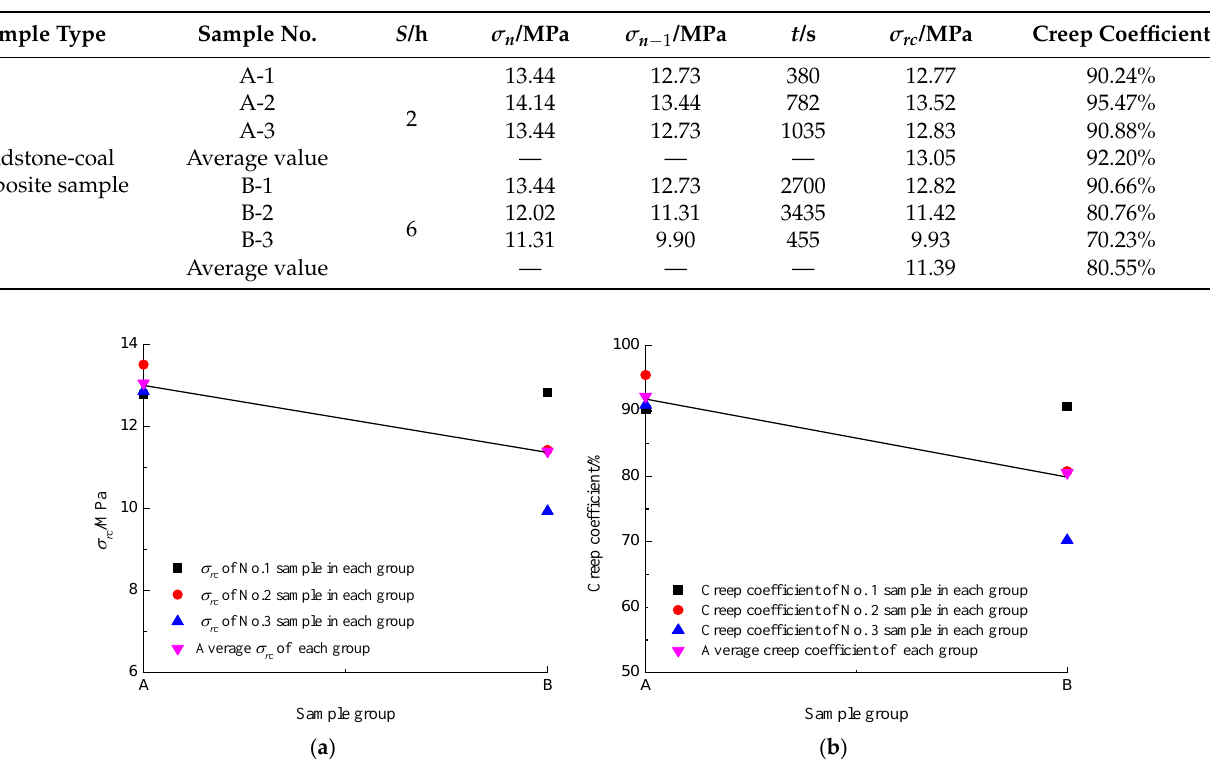
 comparison of composite samples;